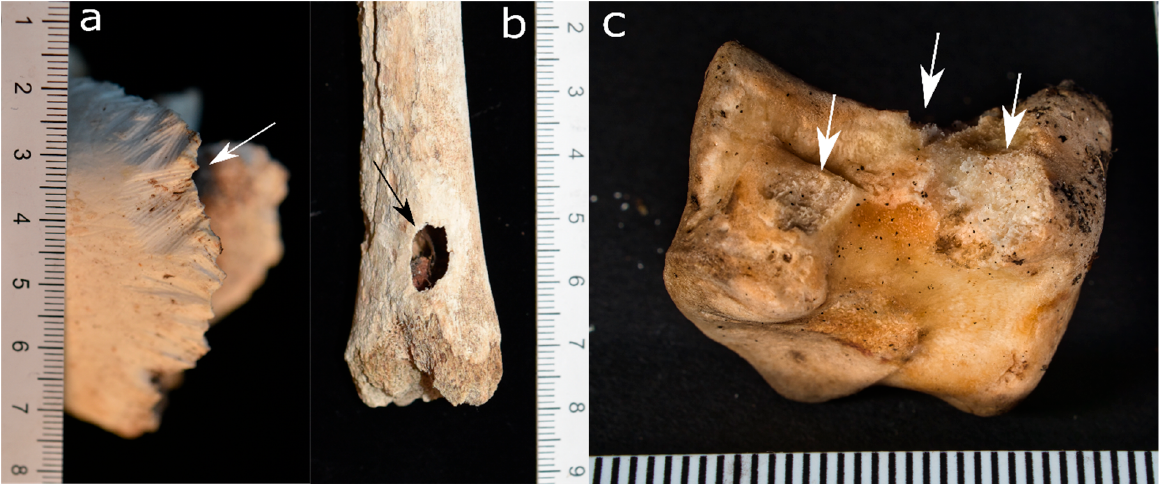
Figure 9. Experimental rodent modifications on animal bones: ( a ) Parallel striations caused by incisors dragging over the bone margins, arranged in fan-shaped patterns (white arrow). ( b ) A “window” created by incisors scraping over the same spot multiple times (black arrow), as modification by captive Degu octodon . ( c ) Nibbled off edges (white arrows) by mice in a Swiss forest. Only the left lesion exhibits the rodent-typical striations.